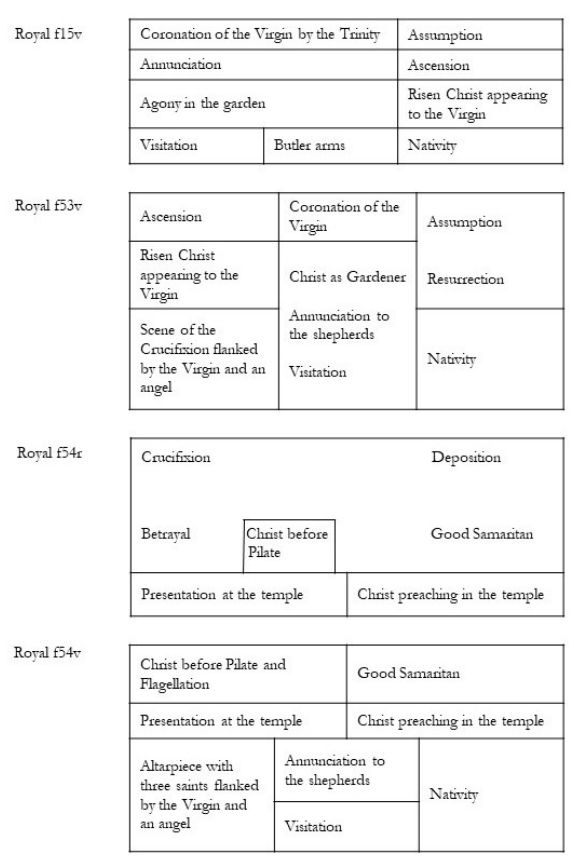
Figure 9. Layout of the pictorial cycles in the Hours of Thomas Butler.